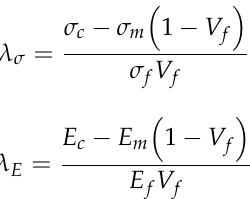
Figure 5. Effect of GF content on impact strength of GF/mPPO composites.